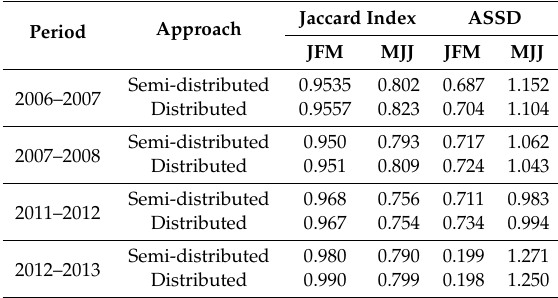
Table 7. Average values of the Jaccard index and ASSD for each simulation approach for the maximum (January, February, March (JFM)) and minimum (May, June, July (MJJ)) snow accumulation periods. Jaccard Period Approach